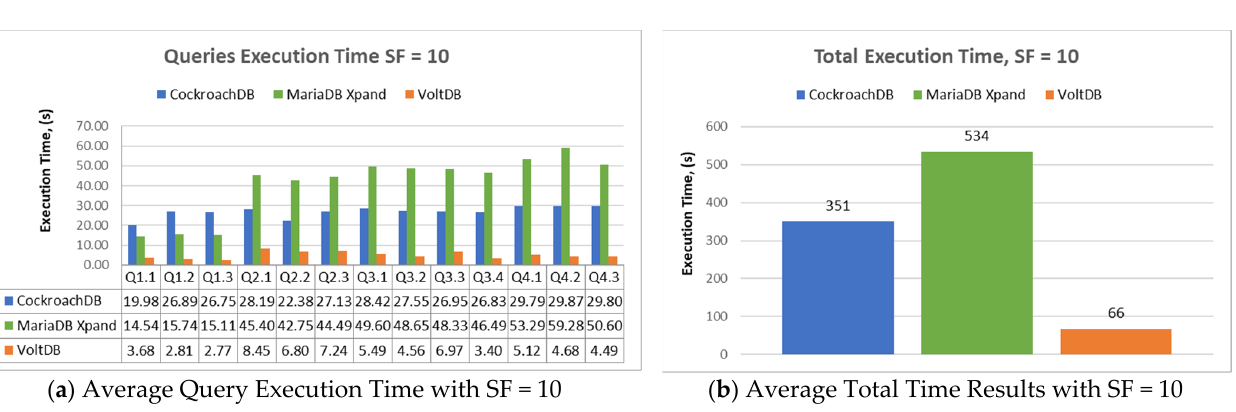
Figure 11. Results of execution time with SF = 10.